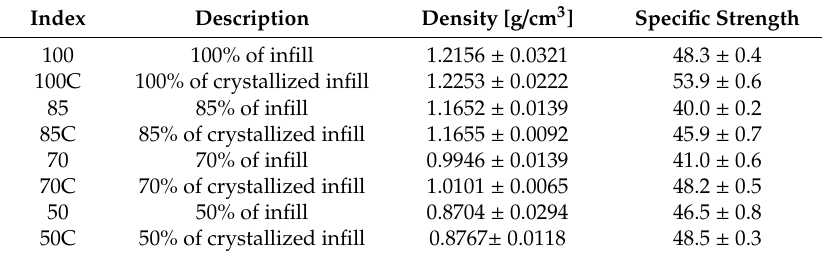
Table 2. Description of the tested materials (density and specyfic